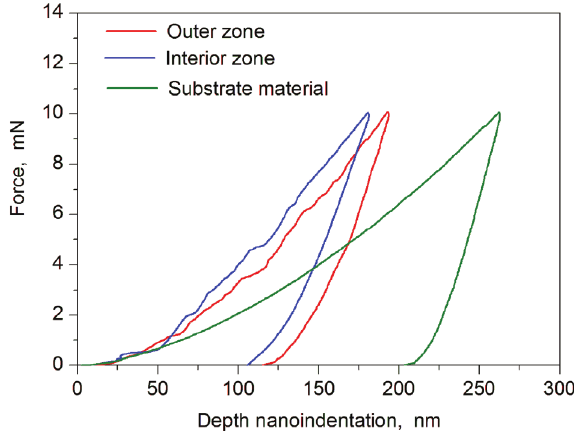
Figure 15: Reduced Young ’ s modulus measurement on the cross section of the aluminide coating and substrate material created with the CVD method, process time 8 h.